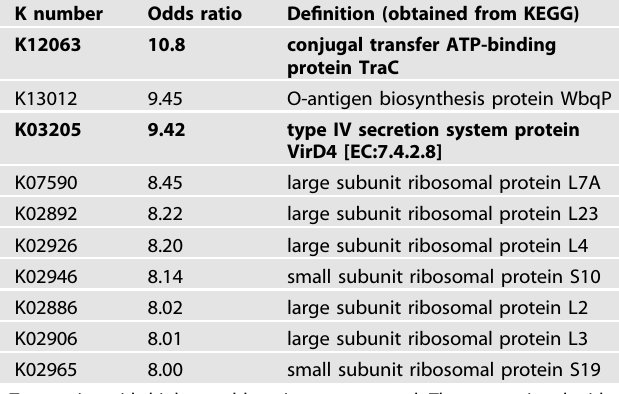
Table 2. Ortholog groups that were enriched into subsequences of top 5% atypical tetranucleotide frequencies within each genome.